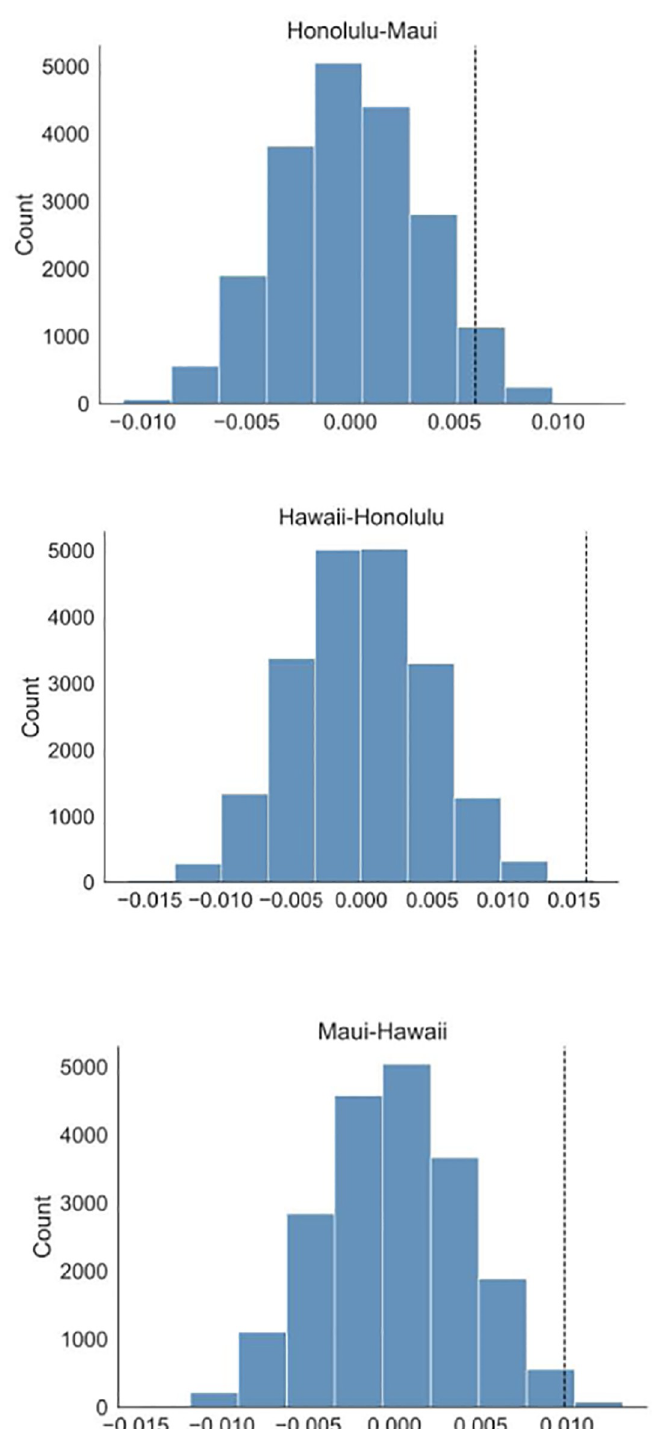
Fig 6. Estimated distribution of permuted difference, Δ , between the mean differences in L 2 -norms for the intervals before Oct. 15 and the one until Jan 15 for the three pairs of counties. The observed values, shown by black vertical lines, clearly suggest that the hypotheses of equality of the mean differences for the three pairs of counties should be rejected.